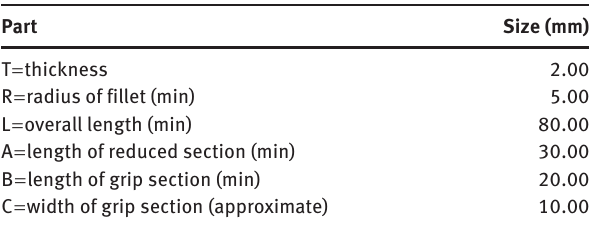
Table 1: Dimensions of subsize specimen parts for tensile test shown in Figure